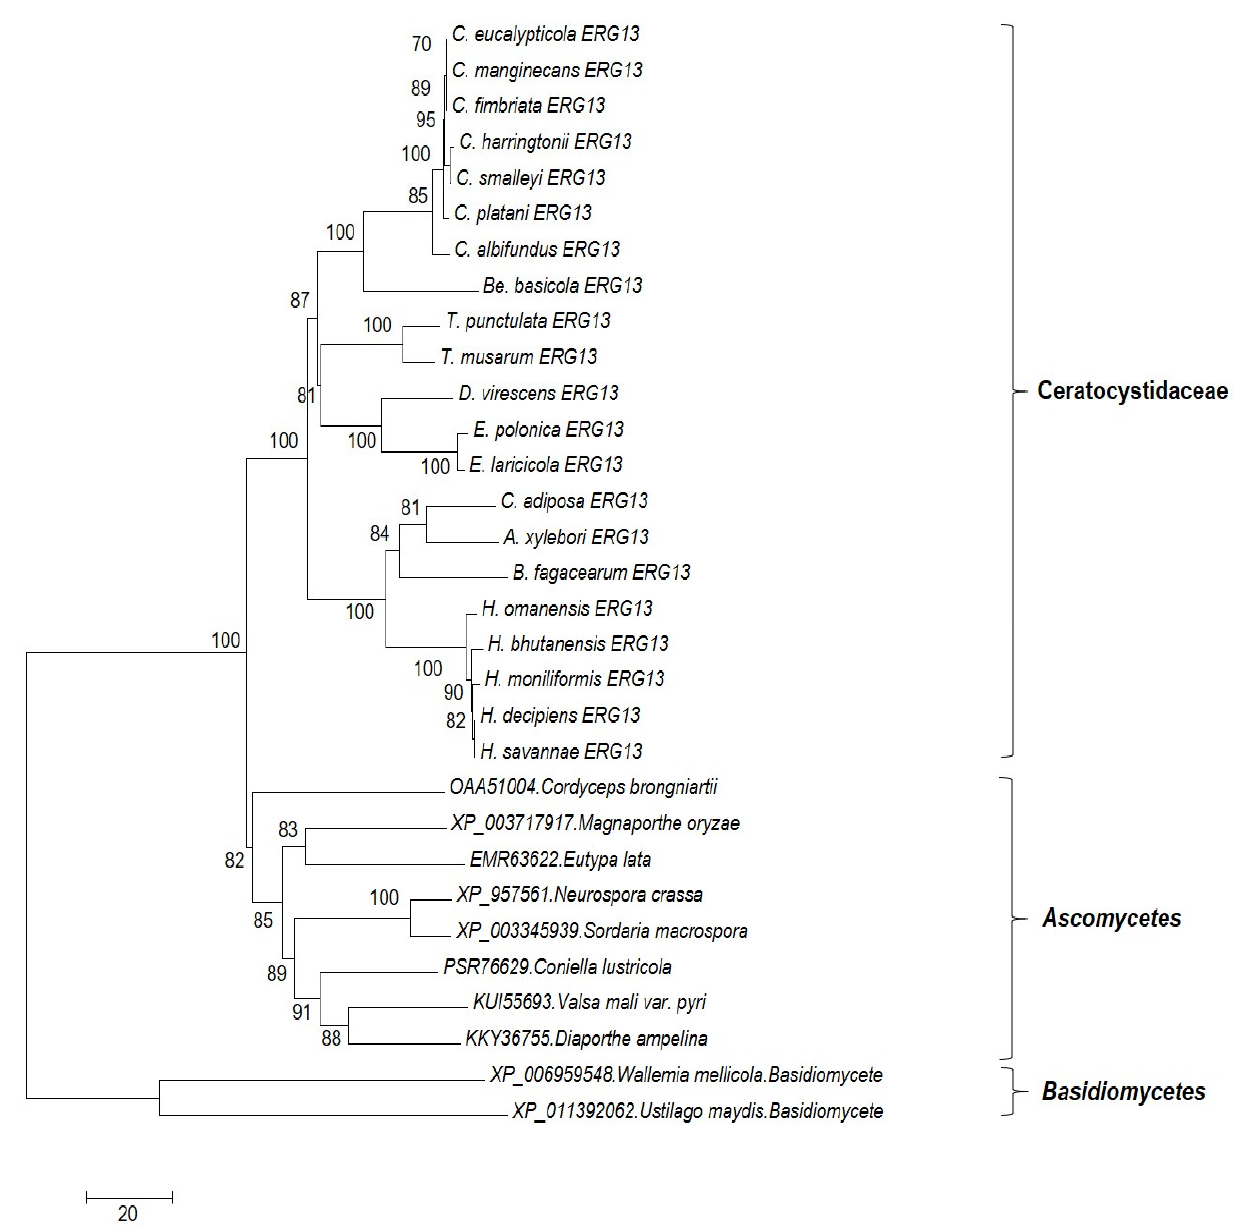
Figure 4. Phylogenetic tree performed on ERG13 protein sequences. This tree was constructed inferred using the maximum likelihood method using MEGA7 software. The optimal tree is shown. The percentage of replicate trees in which the associated taxa clustered together in the bootstrap test (1000 replicates) is shown next to the branches. The analysis involved 46 amino acid sequences. All positions with less than 95% site coverage were eliminated. That is, fewer than 5% alignment gaps, missing data, and ambiguous bases were allowed at any position. There was a total of 442 positions in the final dataset. Tree includes ERG13 proteins from one or more species of the following genera in the family Ceratocystidaceae: Ceratocystis , Huntiella , Thielaviopsis , Bretziella , Endoconidiophora , Ambrosiella , Dadidsoniella and Berkeleyomyces .